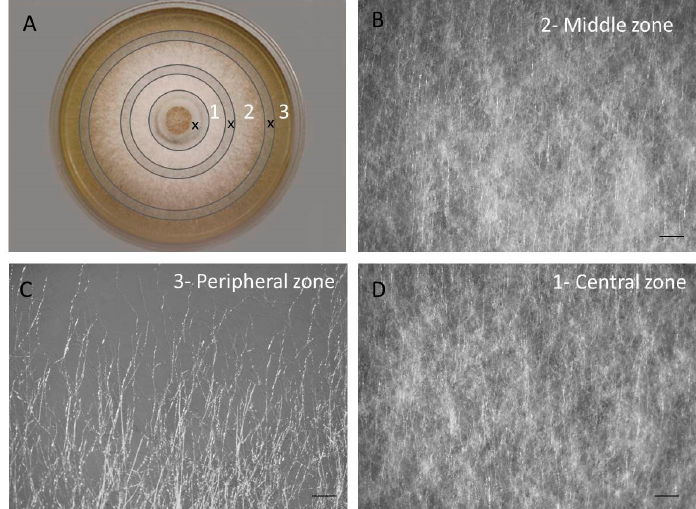
Figure 1. Morphology of the F. velutipes colony. ( A )—Three concentric zones distinguished in the surface colony of F. velutipes . The crossed-out areas (x) were removed to avoid overlapping zones. ( B – D )—Hyphae morphology of the colony zones. Scale bar represents 500 µm.